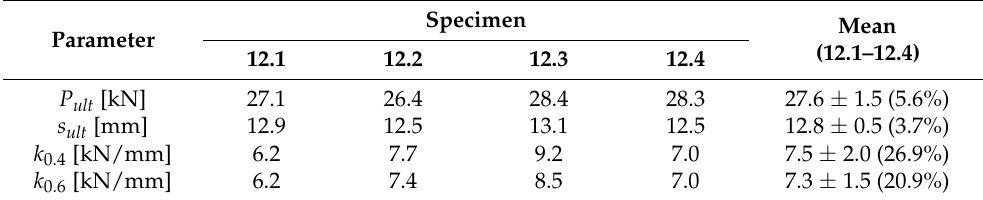
Table 11. The results of the push-out tests of the shear connections with 12 mm screws and with toothed-plate connectors (type C2-50/M12G, Bulldog) (per one connector).